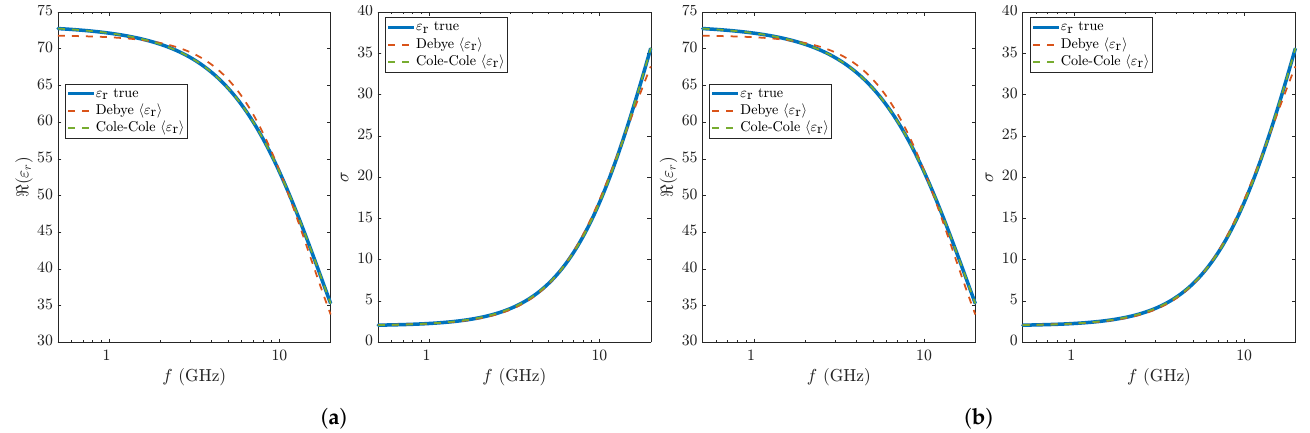
Figure 3. Real part of relative permittivity and conductivity of synthetic data (100 mg/dL glucose concentration) and Debye’s and Cole–Cole’s fitted curves. LMA ( a ) and VPA ( b ) with Set B of initial points are used.